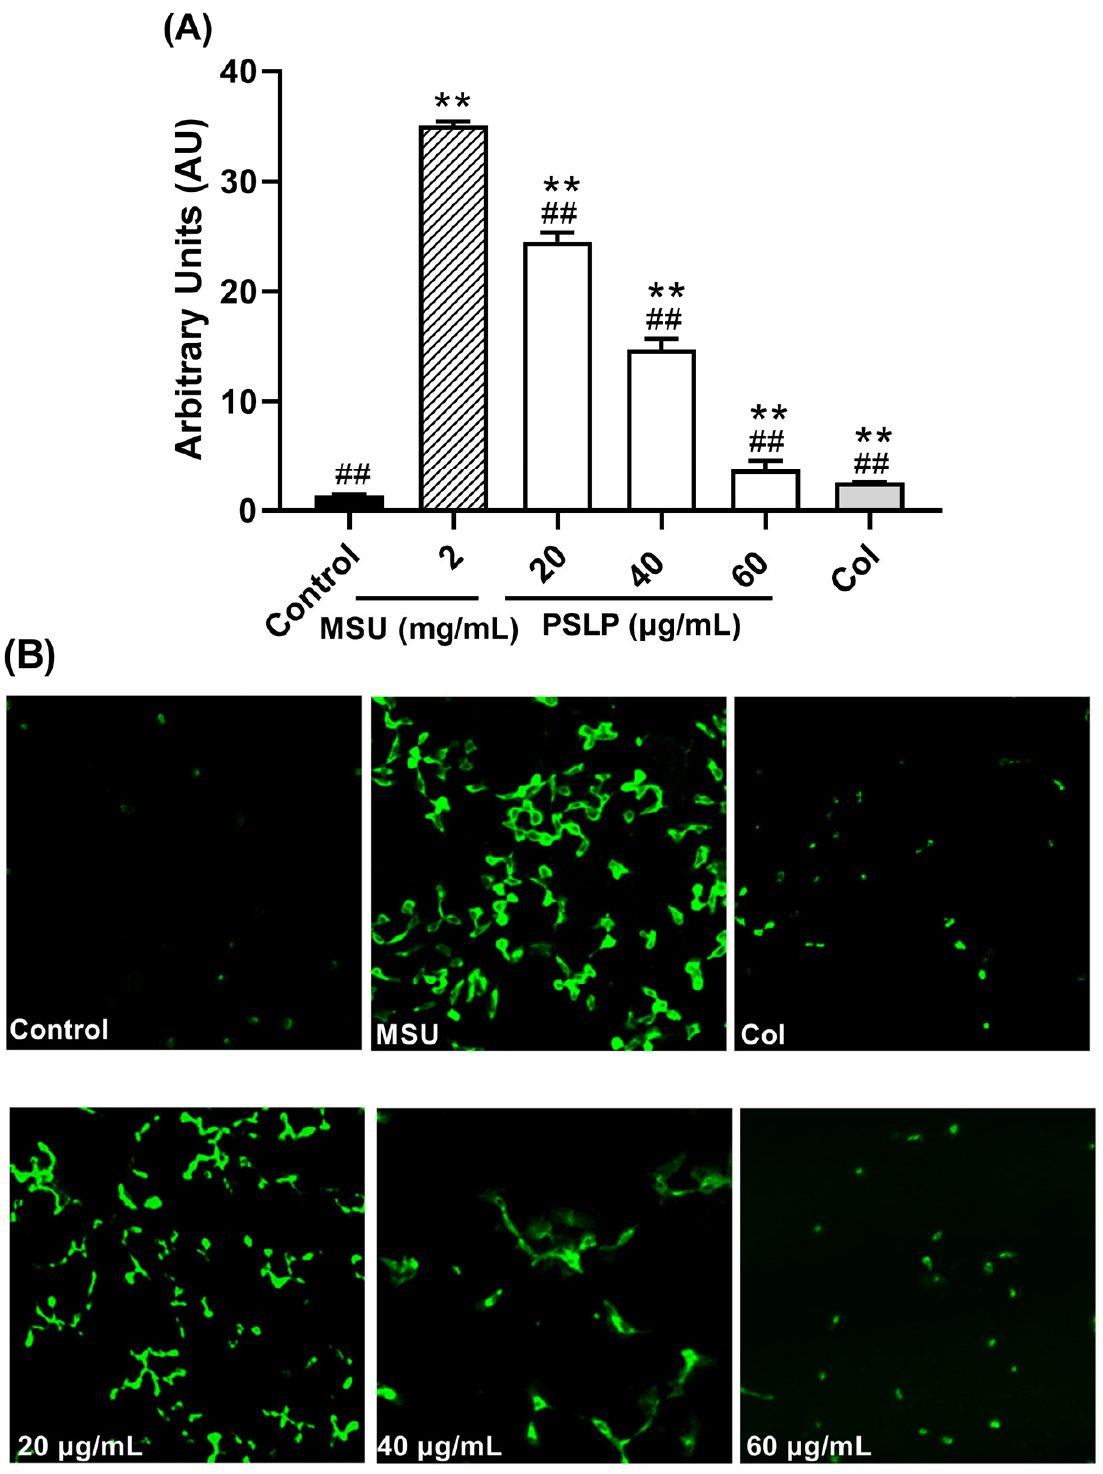
Figure 6. Effect of PSLP on intracellular ROS levels in MSU-stimulated RAW264.7 cells ( A ); ROS fluorogram of RAW264.7 cells ( B ). The values were expressed as means ± SD ( n = 3), ** p < 0.01 vs. the control group. ## p < 0.01 vs. the MSU group.